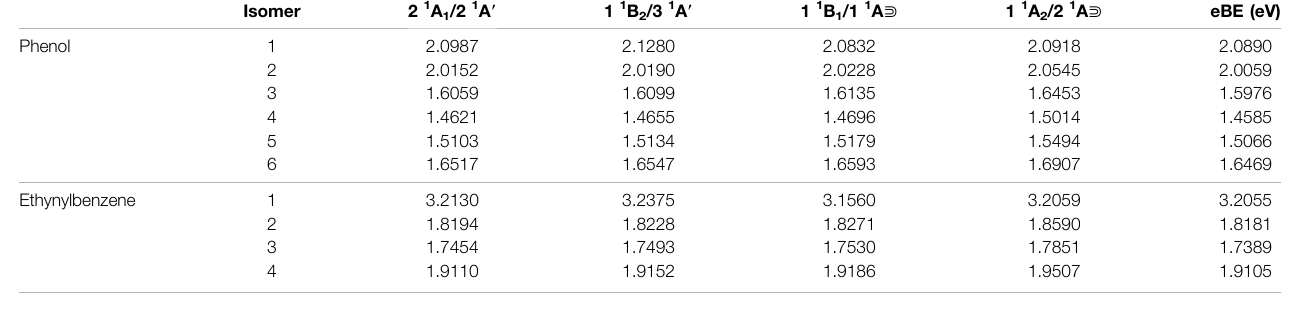
TABLE 2 | The singly deprotonated anion derivatives eBEs and excited state transition energies. Isomer